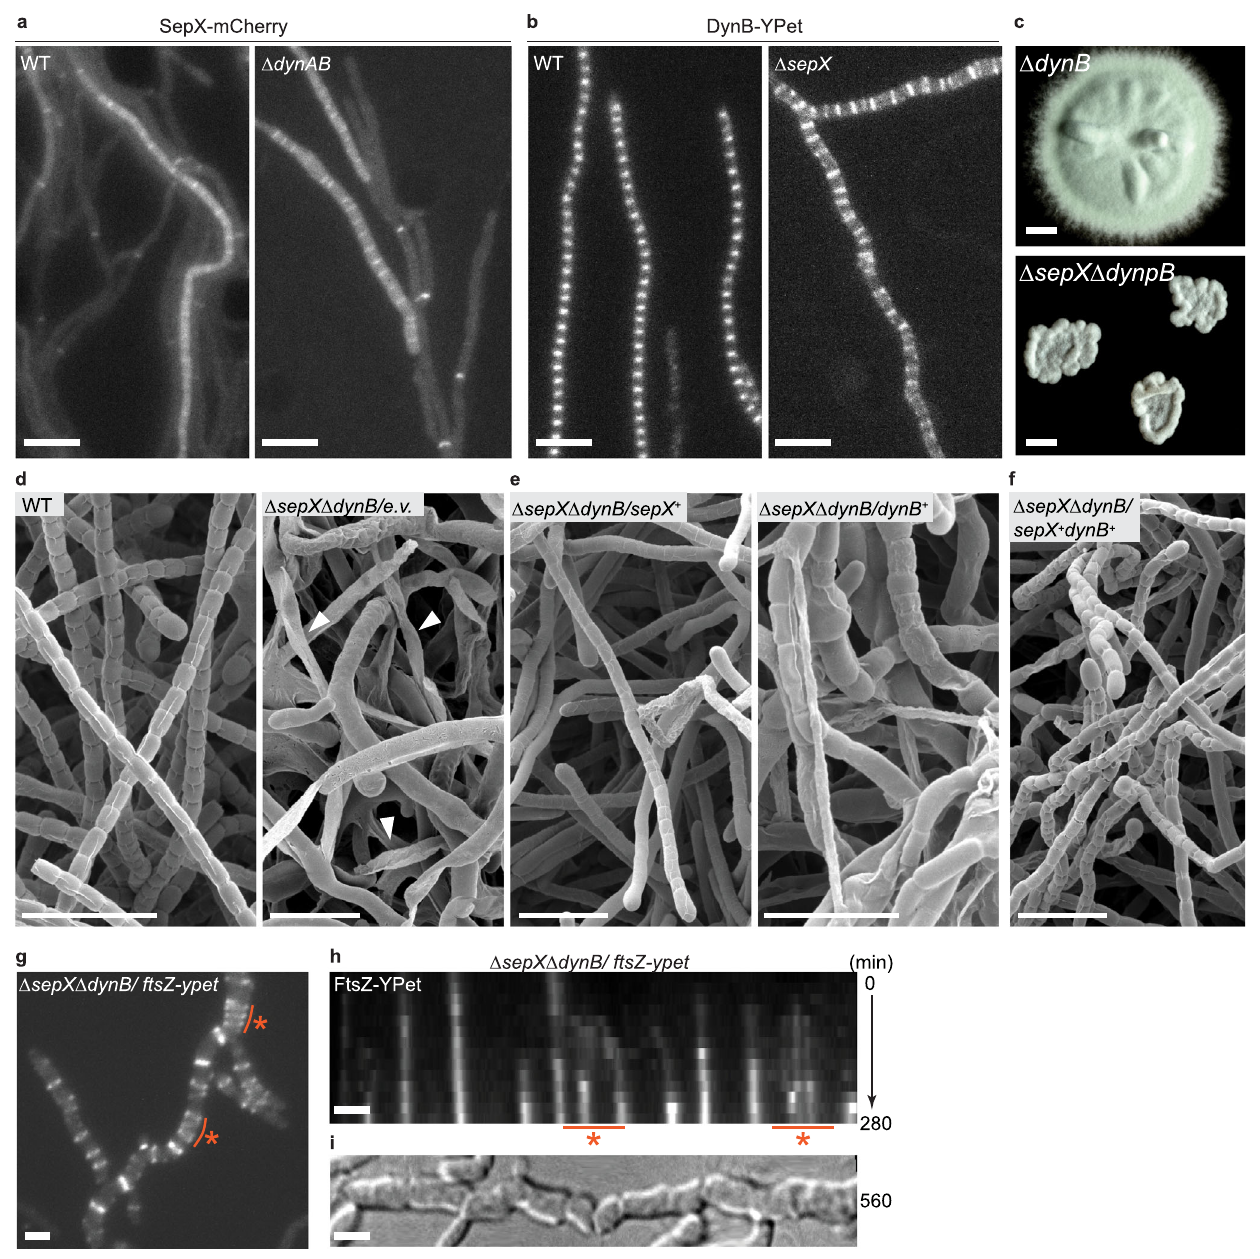
Fig. 6 SepX and DynB function independently during sporulation but cause a synthetic sporulation defect when deleted together. a , b Microscopic analysis showing the subcellular localization of SepX-mCherry or DynAB-YPet in the wild type (MB256, SS92) or in the absence of either dynAB (MB1270) or sepX (SS155). Data shown are representatives of experiments performed in duplicate. Scale bars: 5 μ m. c Colony morphology of the Δ dynB mutant (SS2) compared to the Δ sepX Δ dynB double mutant (SV57). Strains were grown for 3 days on solid MYM. Scale bar: 1 mm. ( d – f ) Cryo-SEM images of S. venezuelae sporogenic hyphae, including ( d ) the wild type (WT) and the Δ sepX Δ dynB double mutant carrying an empty plasmid (MB1099), white arrow heads in right panel point at lysed hyphae, e the Δ sepX Δ dynB double mutant complemented with either sepX (MB1102) or dynB (MB1101) expressed from the ermE* promoter ( + ), or f the Δ sepX Δ dynB double mutant complemented with both sepX and dynB (MB1103). Scale bars: 5 μ m. Data shown in d – f are representatives of at least seven images. g Still images taken from Supplementary Movie 3 showing FtsZ-YPet localization in the Δ sepX Δ dynB mutant (MB1111). Orange line and asterisk denote regions of migrating Z-rings. Scale bar: 2 μ m. h , i Kymograph showing FtsZ-YPet distribution in a sporulation Δ sepX Δ dynB hypha presented in g with the corresponding DIC image ( i ) displaying the terminal sporulation phenotype. Orange line and asterisk in ( h ) correspond to the region highlighted in g . Scale bars: 2 μ m. Data shown in g – i are representatives for experiments performed in